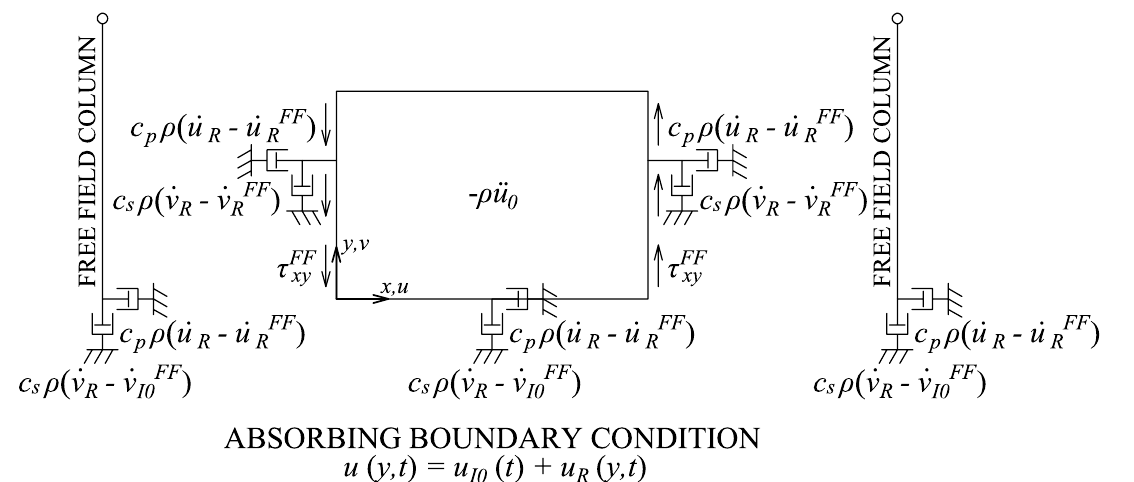
Figure 1. Boundary and loading conditions for both FF and 2D